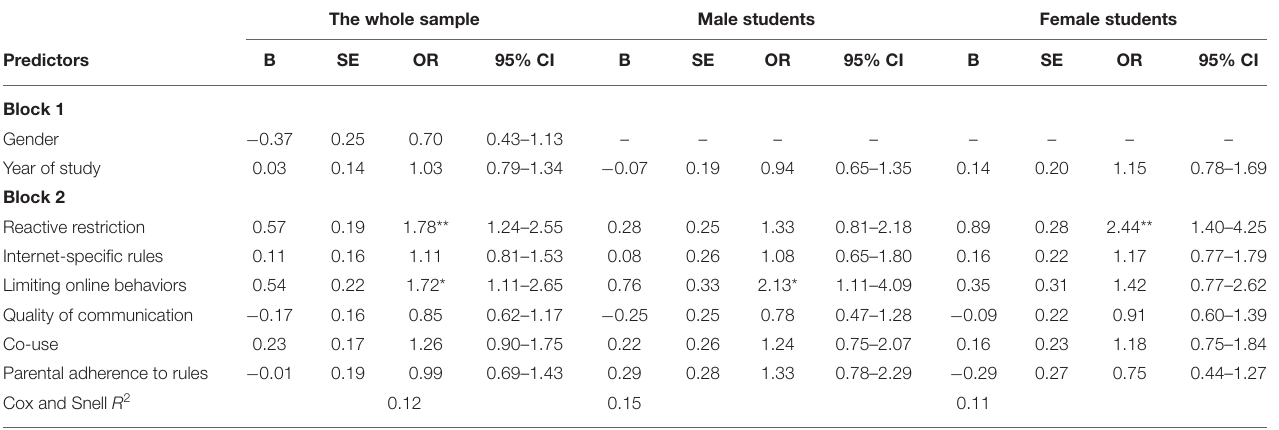
TABLE 5 | Logistic regression analysis of the prediction of SNA by parenting behaviors. The whole